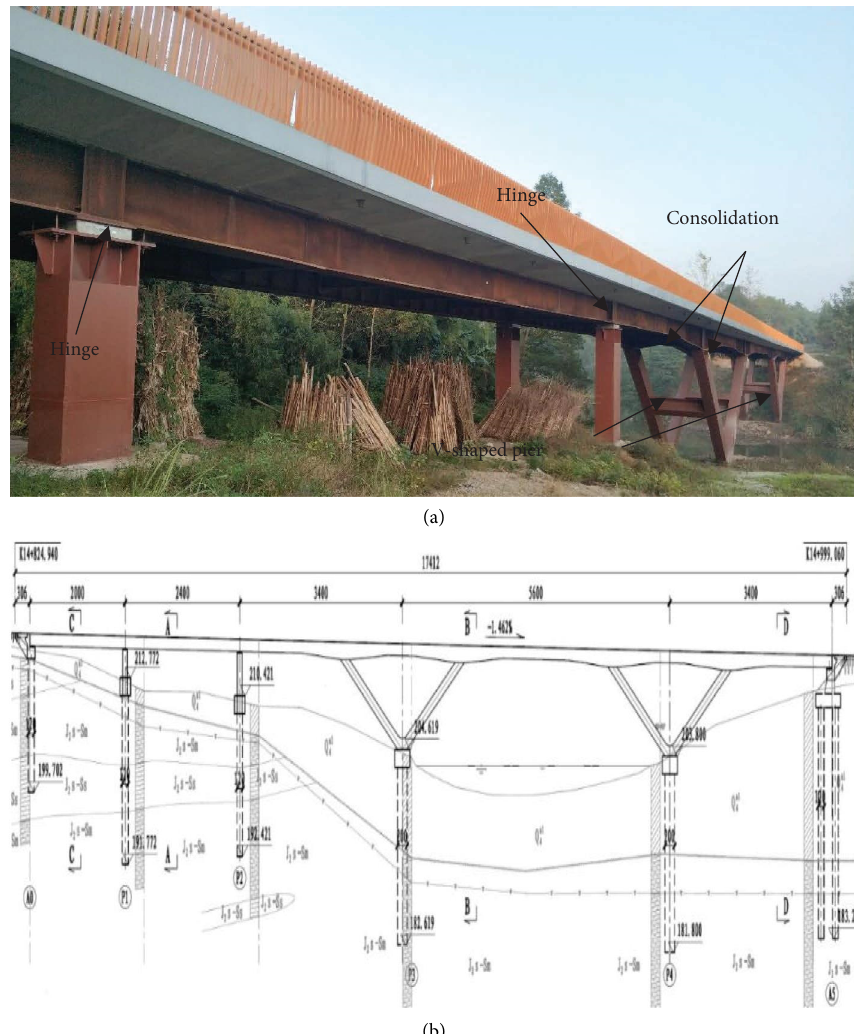
Figure 1: Elevation of the bridge: (a) in situ photo of bridge; (b) elevation of the bridge.